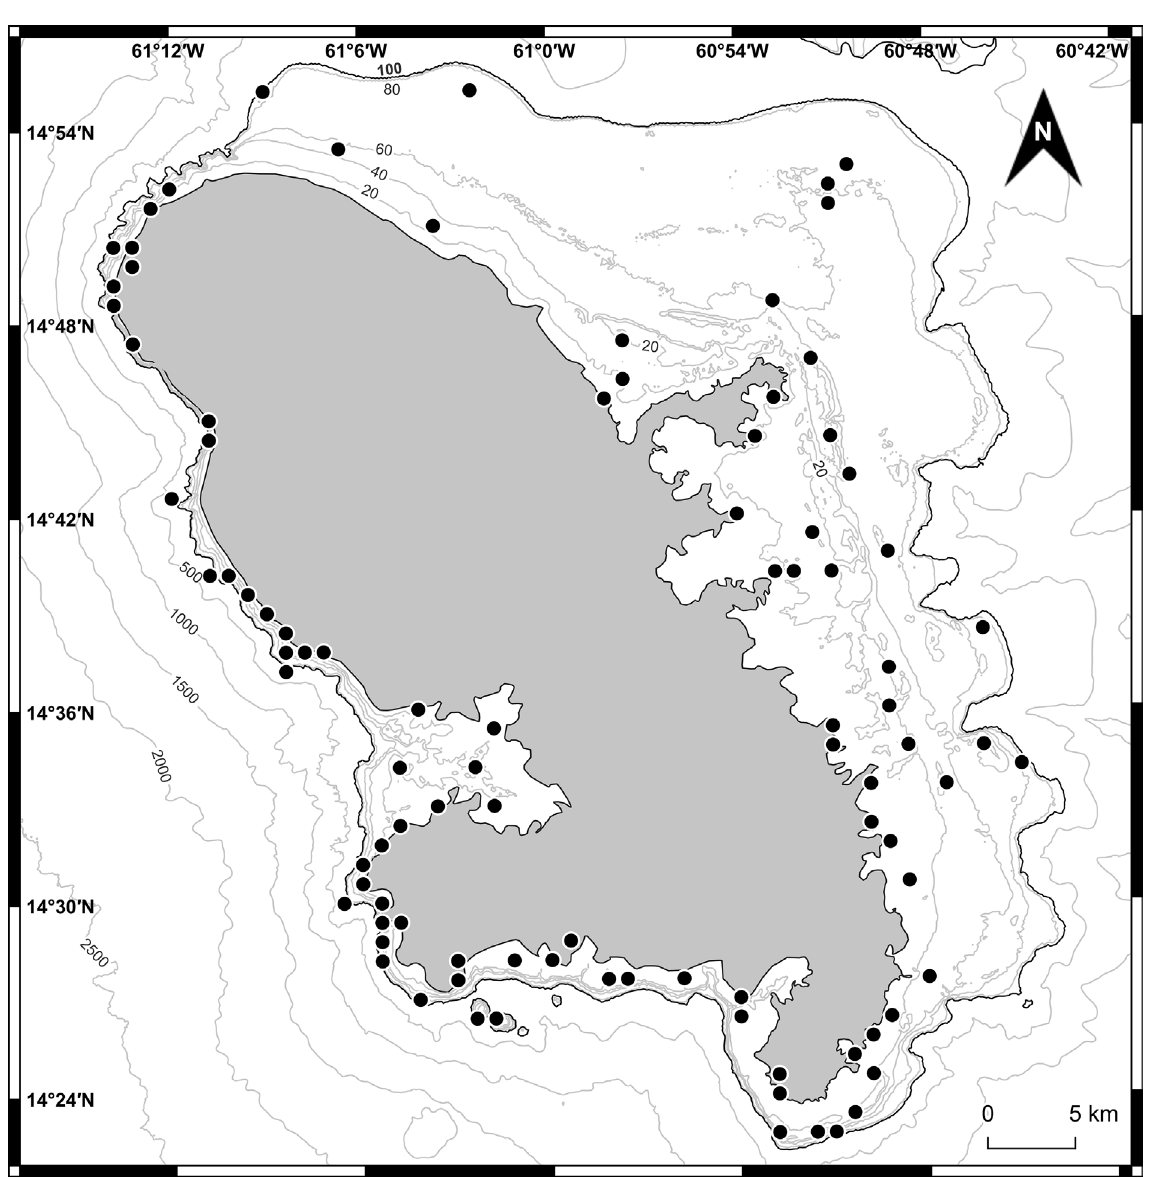
Fig. 1. Madibenthos sampling stations with occurrences of sea spiders in Martinique. Bathymetric range is shown by grey isolines each 20 m (0–100 m depth) and each 500 m (deeper than 500 m). The 100 m isobath (above which most samplings were performed) is marked by a black isoline. Sampling stations are indicated as black circles. See Sabroux et al. (2019b) for alternative